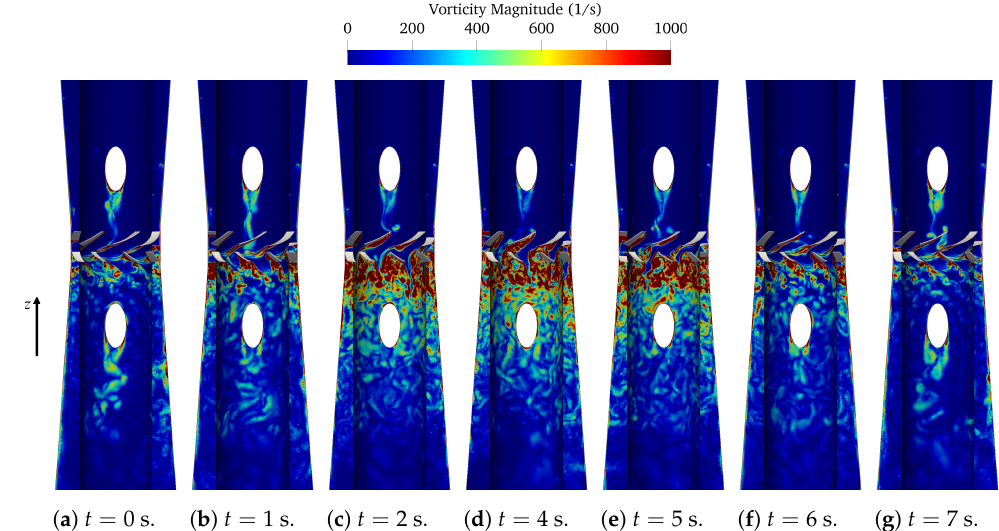
Figure 5. Zoomed-in view of the vorticity magnitude at various time steps during the transient sequences in turbine mode. The results are displayed on a meridional plane and a cylinder (midpoint radius between hub and shroud) cutting the domain. The flow is from top to